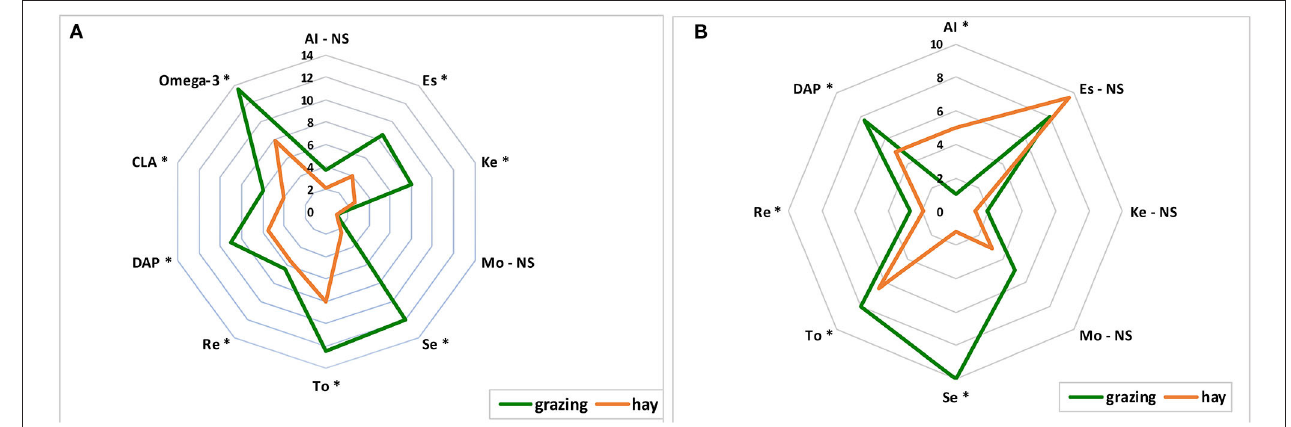
FIGURE 1 | Qualitative profile of goat milk (A) and cheese (B) from grazing and hay feeding system [from (35)]. Al, alcohols; Es, esters; Ke, ketones; Mo, monoterpenes; Se, sesquiterpenes; To, tocopherol; Re, retinol; DAP, degree of antioxidant protection; CLA, conjugated linoleic acid. * P < 0.05; NS = not